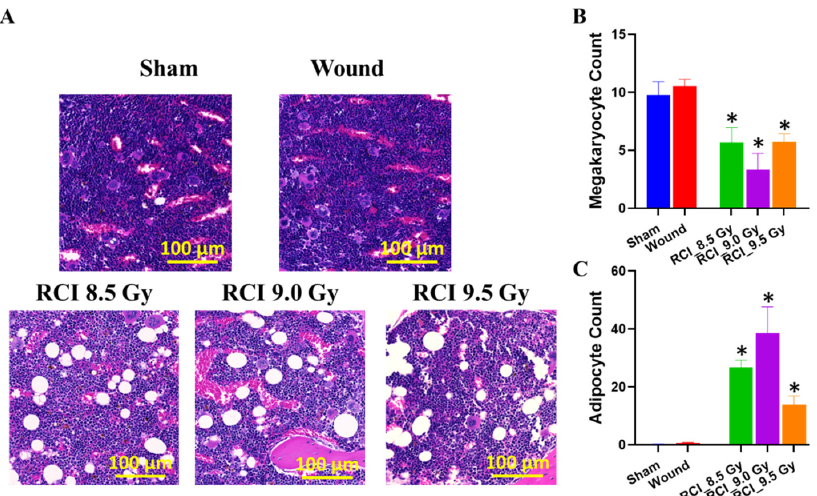
Figure 4. Bone marrow hypocellularity is induced by RCI at different doses. ( A ) Representative images of histological sections of sternum obtained on day 30 post-TBI stained with hematoxylin and eosin (H&E), scale bar: 100 µm. ( B , C ) Quantification of megakaryocyte and adipocyte. * p < 0.05 for RCI vs. sham by one-way ANOVA and Dunnett’s multiple comparisons test; N = 4–13.